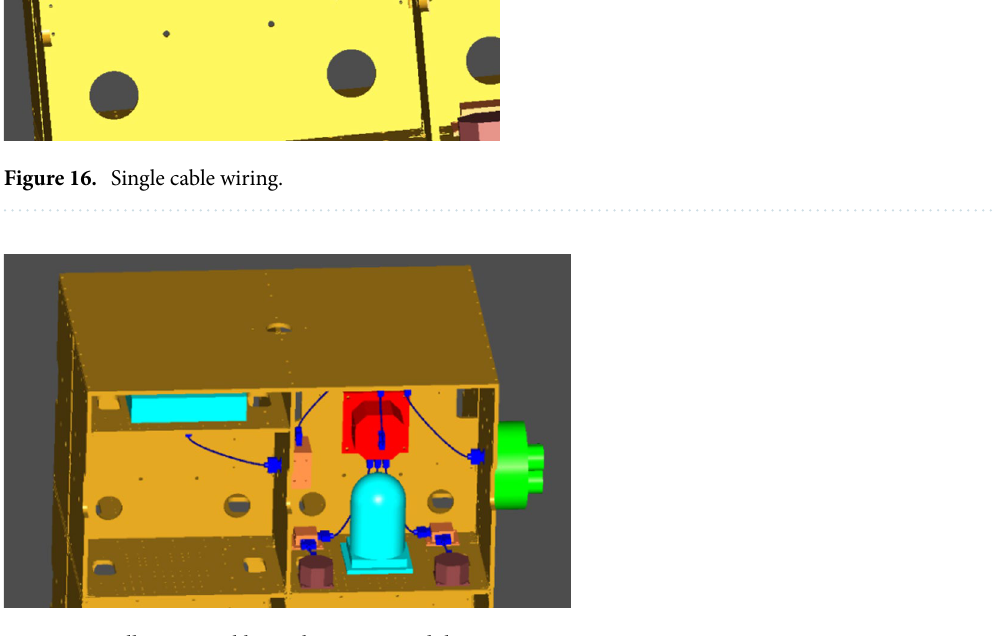
Figure 17. All routing cables in the wiring